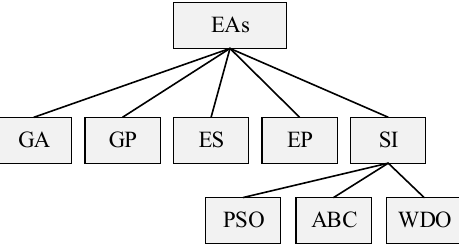
Figure 2. A diagram depicting the main families of evolutionary algorithms.